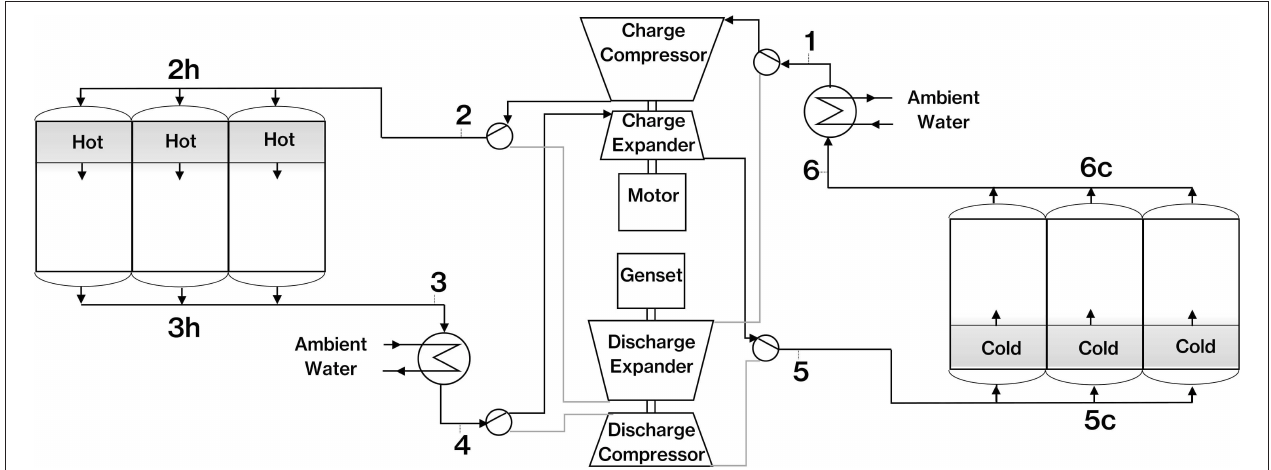
FIGURE 2 | Coupled PTES system in charge mode (note valve arrangement for switching to discharge